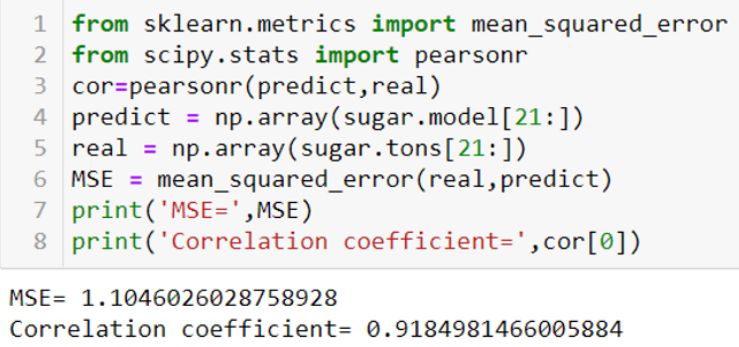
Figure 14. Finding the mean squared difference (MSE) between estimated and real